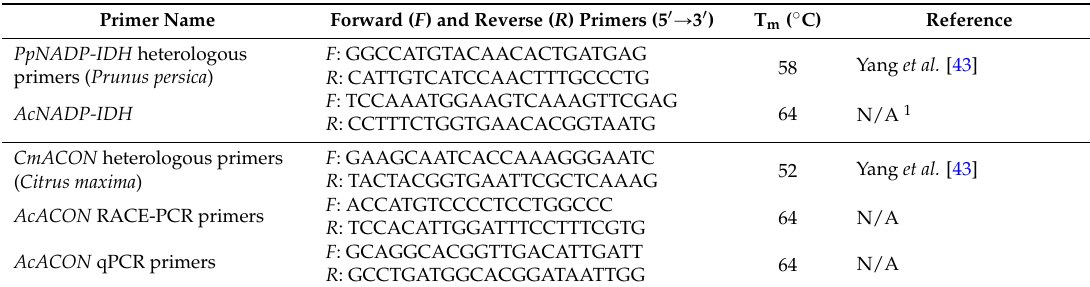
Table 4. Heterologous, degenerate and specific primers used for isolating cDNAs from cherimoya cv. “Concha Lisa”, RACE-PCR and qPCR